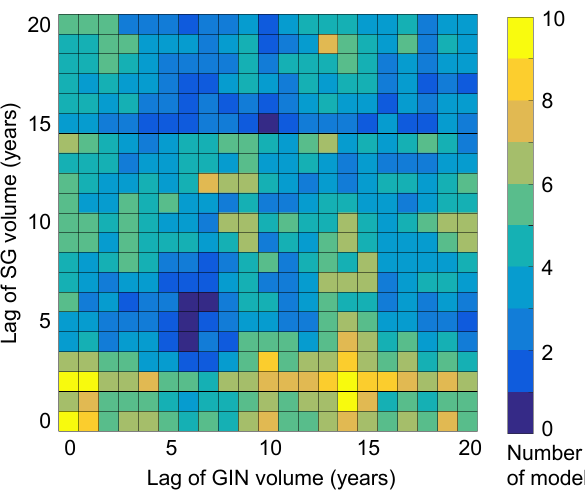
Figure 5. Number of models out of the 14-model subset where a significant correlation was found between the AMOC and the sum of the volumes of deep convection SG + GIN, for different lags of SG (vertical) and GIN (horizontal); deep convection before